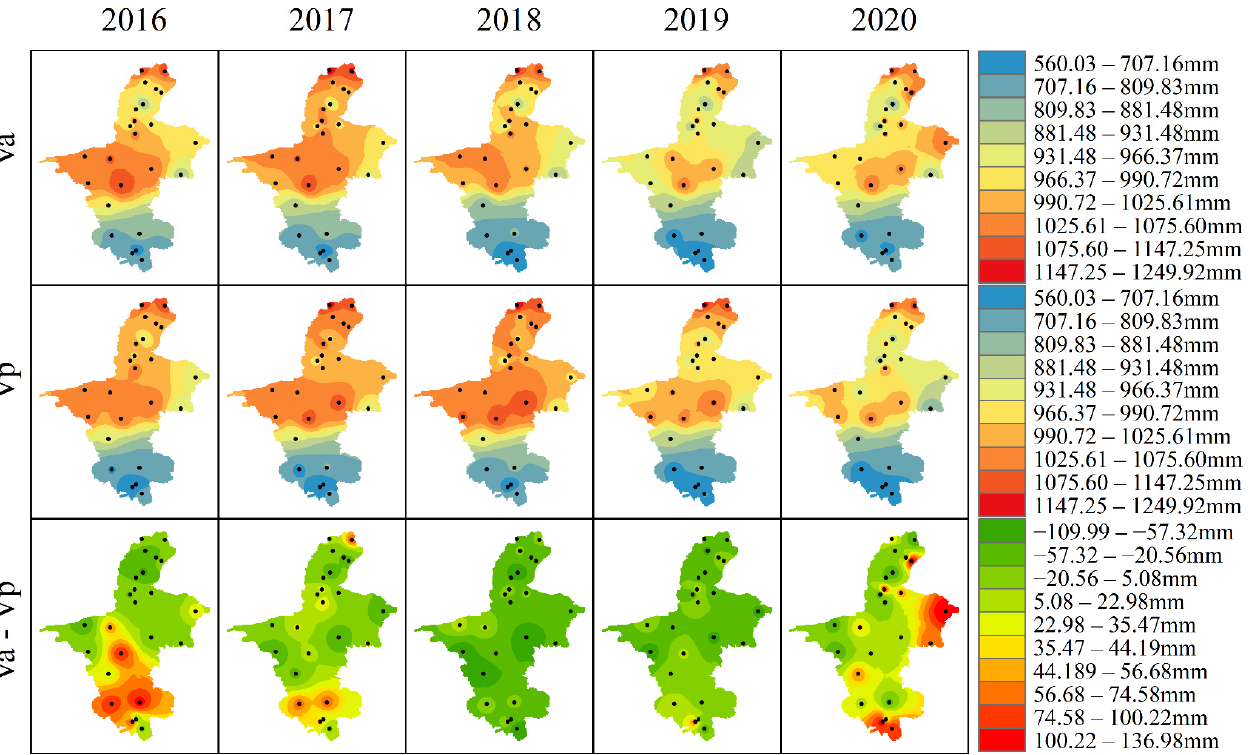
the northern region (green region) has the smallest error, between 2.12 and 3.97%, and the southern region has a larger prediction error.